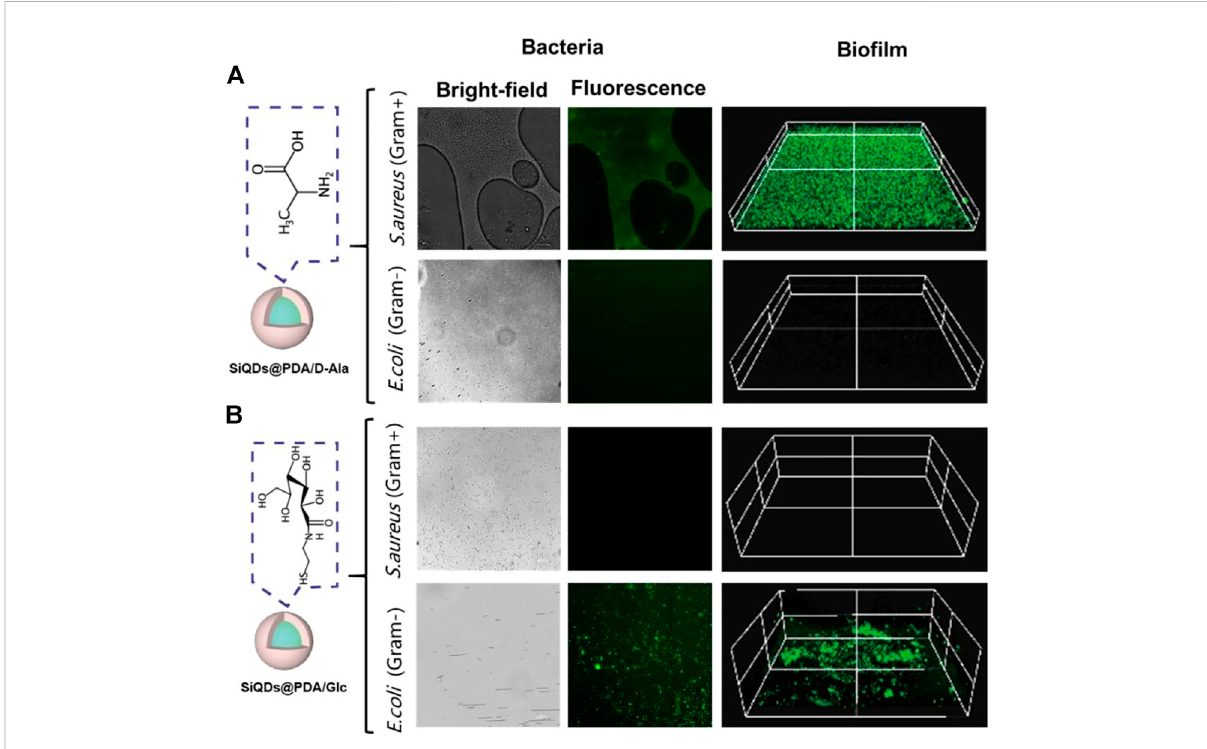
FIGURE 4 Characterization of selective imaging of bacteria and bio fi lms with SiQDs@PDA/D-Ala and SiQDs@PDA/Glc as fl uorescent probes. (A) Optical and fl uorescent imaging result of SiQDs@PDA/D-Ala as the probe and (B) optical and fl uorescent imaging result of SiQDs@PDA/Glc as the